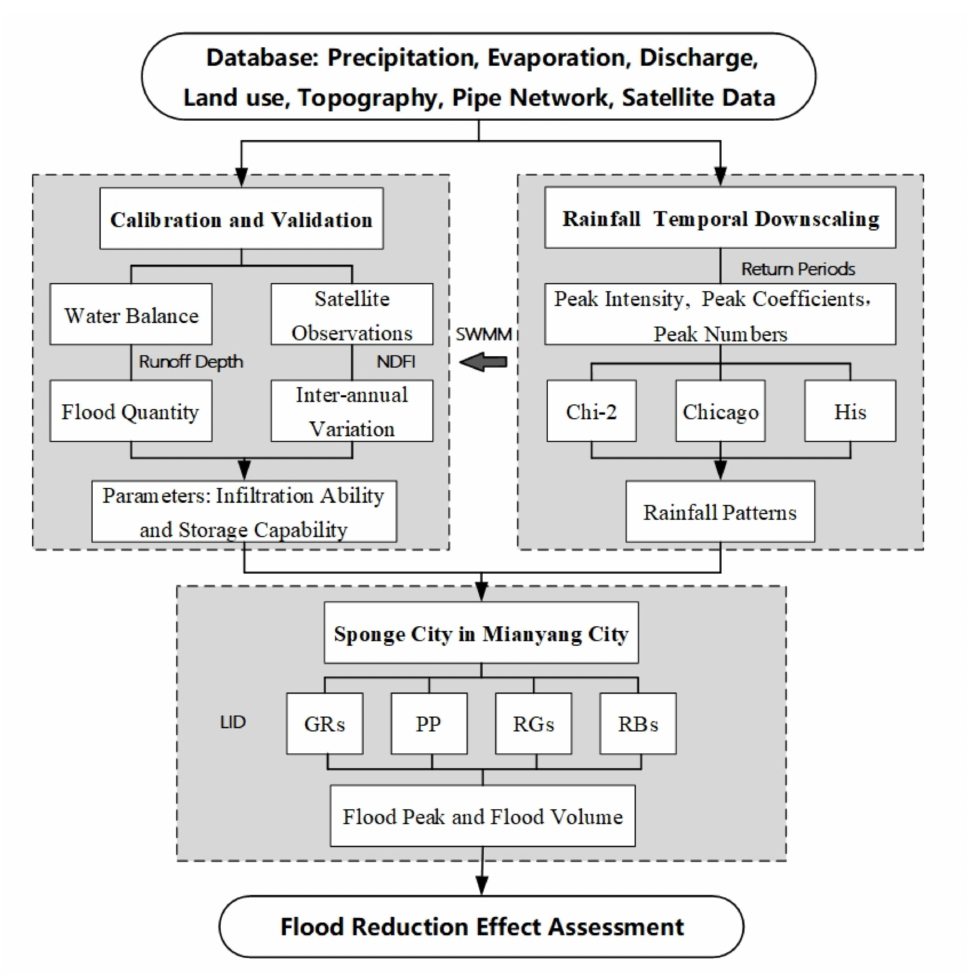
Figure 1. Flowchart of assessment of Sponge City Flood Control capacity based on multi-source validation and depends on different rainfall